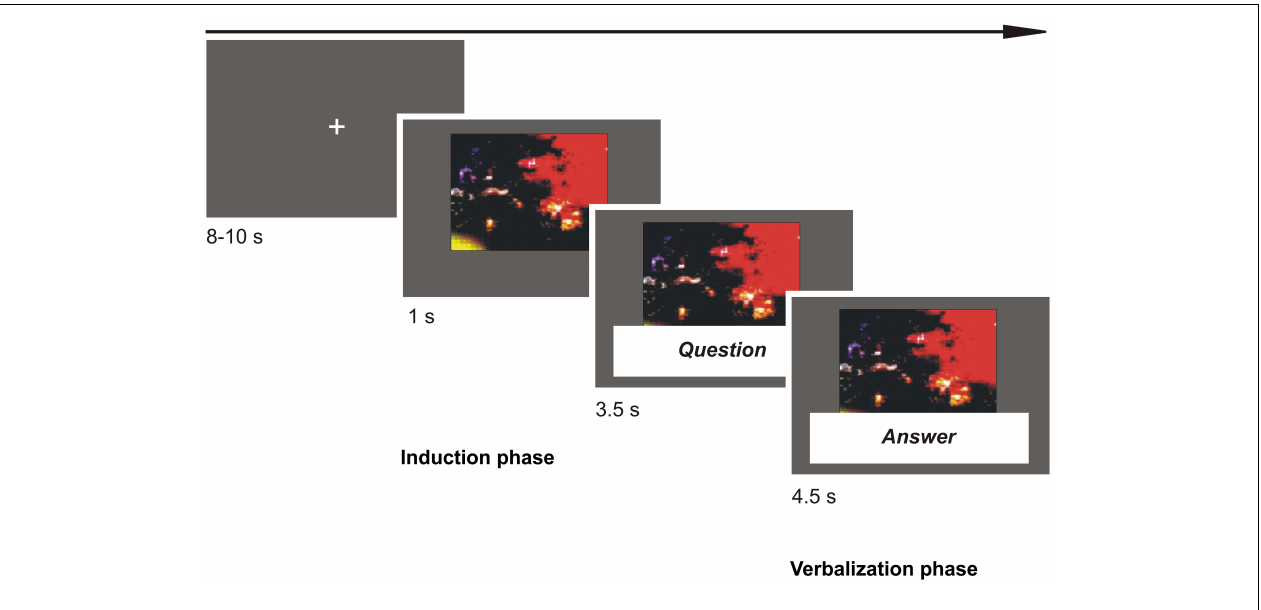
FIGURE 1 |The figure shows a schematic illustration of an experimental trial . First, a picture (emotional or neutral) appeared on the screen for 1s ( induction phase ).Then, the question asking to verbalize in four different ways following our different conditions